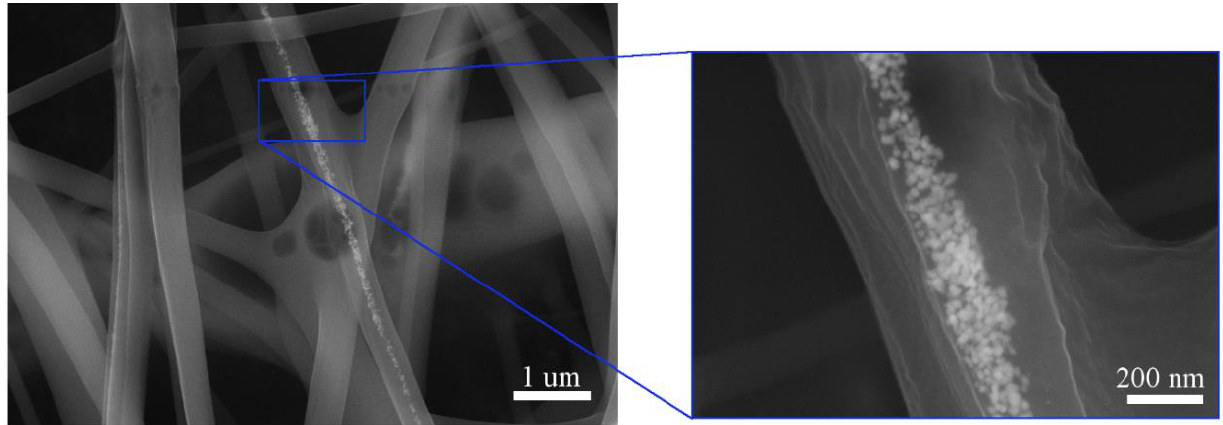
Figure 4. SEM images of ex situ PVA-5AgNPs fibers with detailed view of the AgNPs shape and distribution.